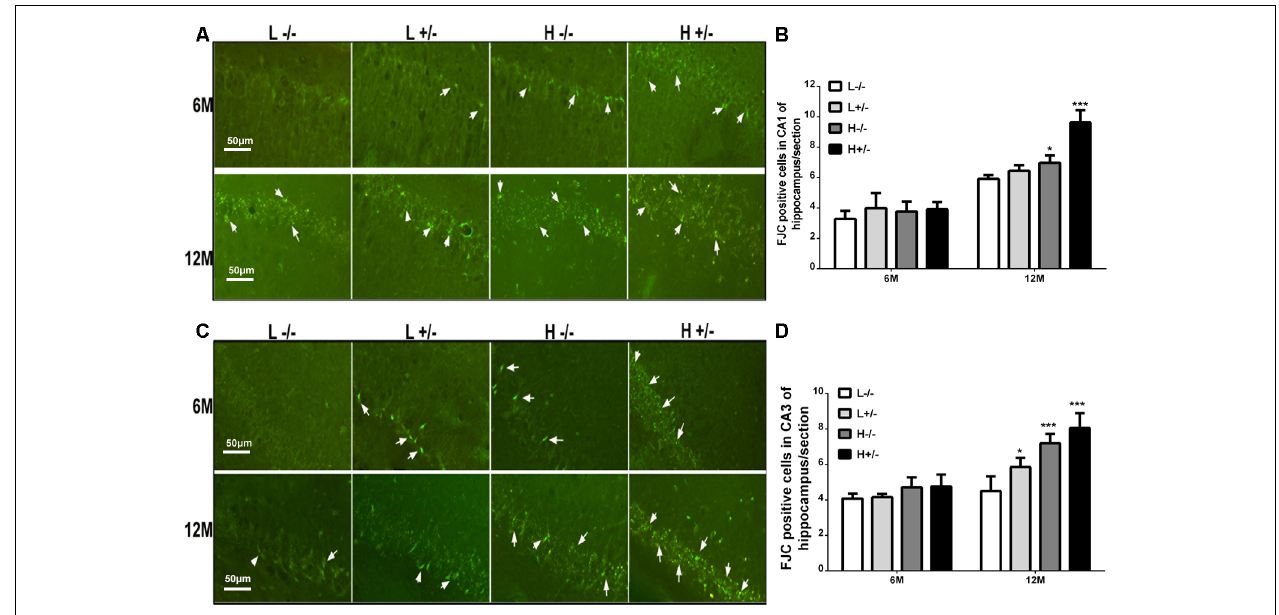
FIGURE 3 | Neural degeneration in the hippocampi of hIAPP − / − and hIAPP − / + mice was accelerated by a high-fat diet. (A) Representative images of Fluoro-Jade C (FJC)-positive staining in the hippocampal CA1 regions of hIAPP − / − and hIAPP + / − mice fed with a high/low-fat diet for 6 or 12 months. White arrows indicate FJC-positive cells. (B) Six sections per mouse were stained, and semiquantitative analysis was performed using ImageJ software. (C) Representative images of FJC-positive staining in the hippocampal CA3 regions of hIAPP − / − and hIAPP + / − mice fed with a high/low-fat diet for 6 or 12 months. White arrows indicate FJC-positive cells. (D) Six sections per mouse were stained, and semiquantitative analysis was performed using ImageJ software. L − / − denotes hIAPP − / − mice on a low-fat diet; L + / − denotes hIAPP + / − mice on a low-fat diet; H − / − denotes hIAPP − / − mice on a high-fat diet; H + / − denotes hIAPP + / − mice on a high-fat diet. n = 6, ∗ p < 0.05, ∗∗∗ p < 0.001 compared with the L − / − group.